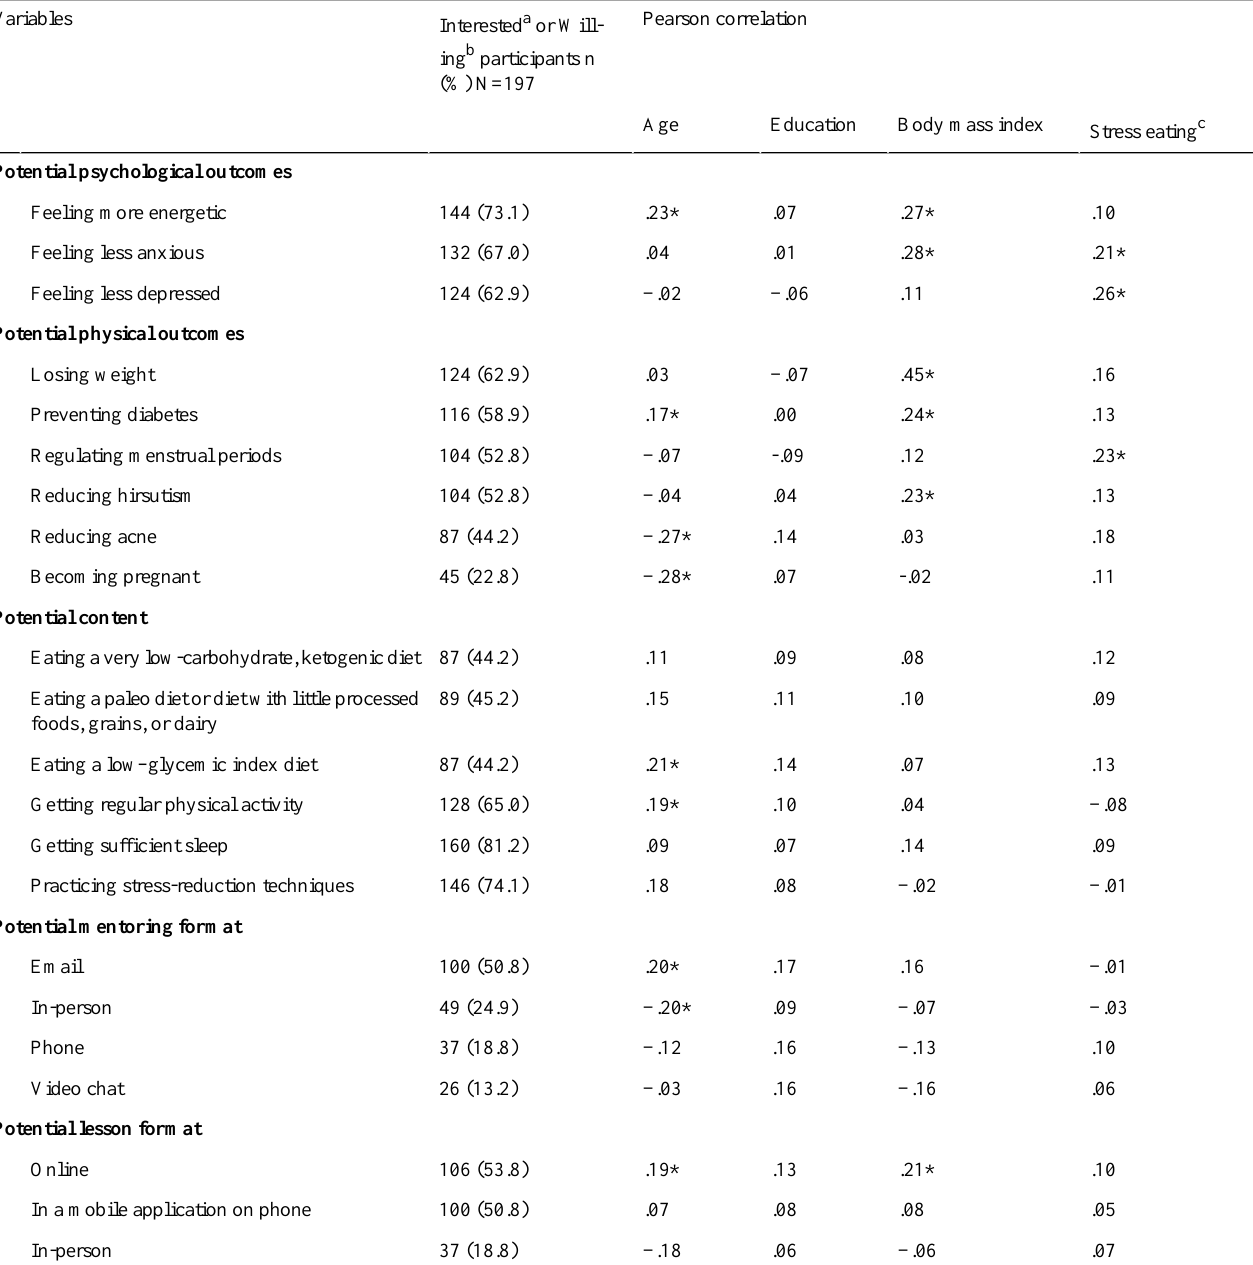
Table 2. Associations between interest/willingness ratings in potential program features and selected respondent variables.